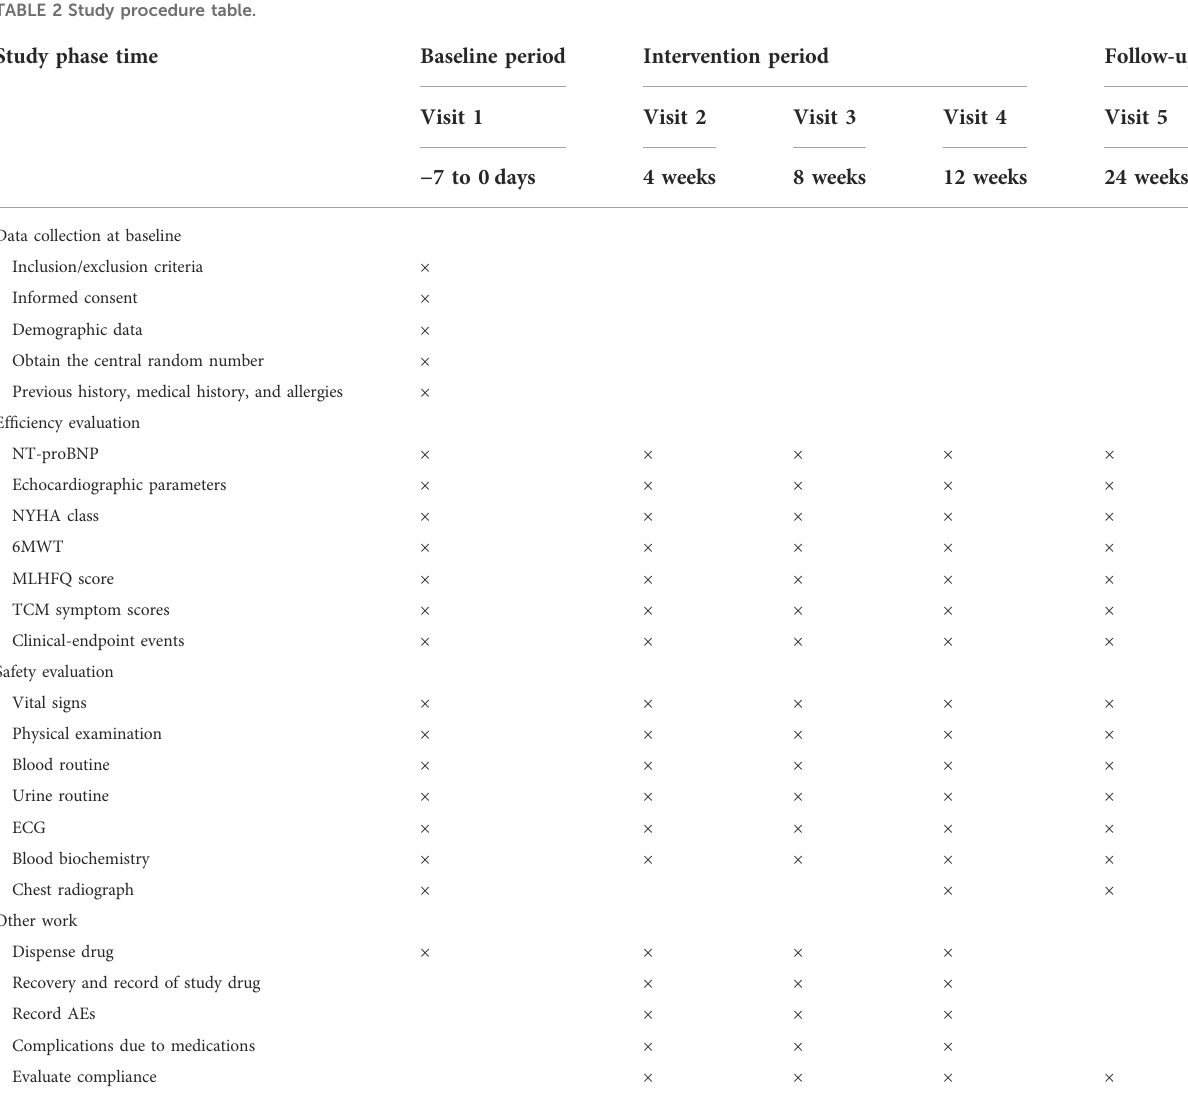
TABLE 2 Study procedure